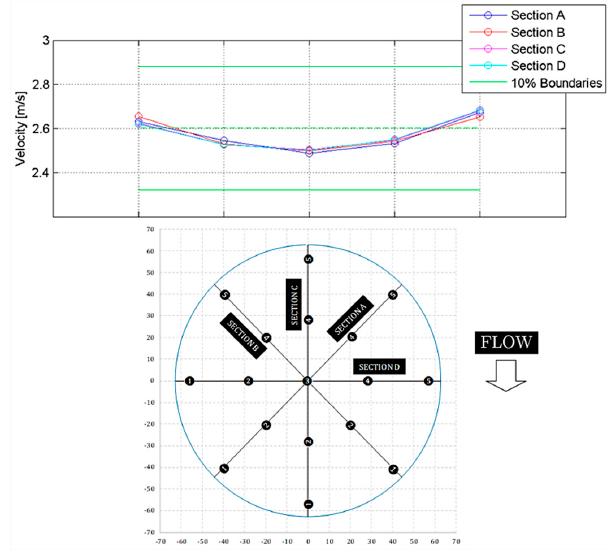
Figure 23. Point velocity profile for the physical model test.